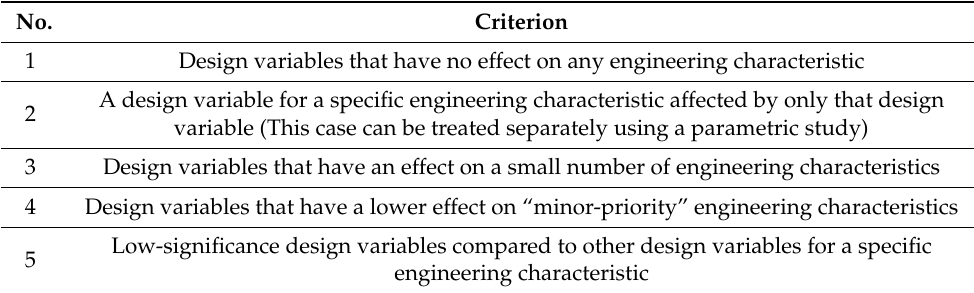
Table 9. Design variable screening criteria.